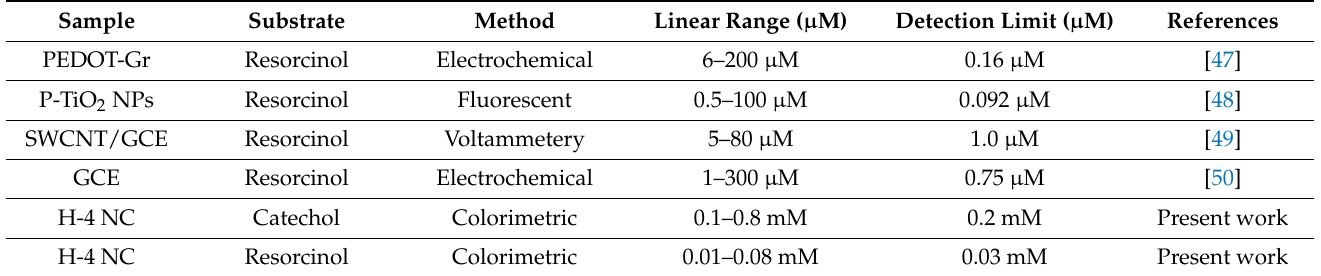
Table 5. Range and limit of detection (LOD) for catechol and resorcinol by various PPO-mimics.